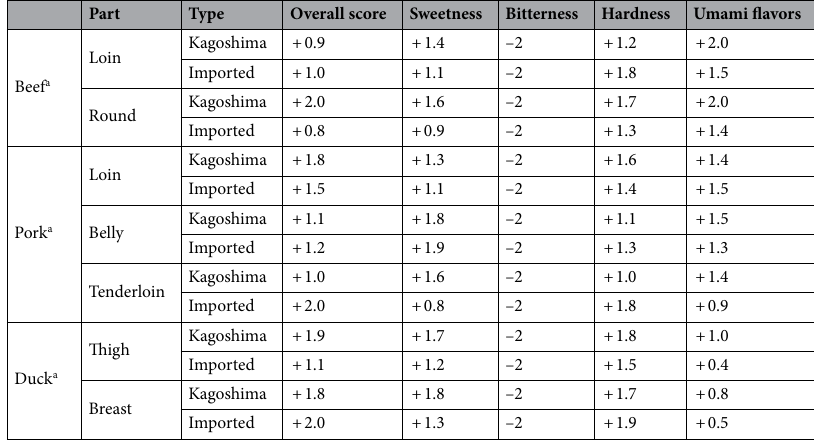
Table 3. Overall sensory evaluation of cooked meat. a Cooked meat samples (beef, pork, and duck) were comprehensively evaluated for sweetness, bitterness, hardness, and umami flavors using sensory evaluation. Each item was rated on a five-point scale, ranging from + 2 to –2. A higher score indicated better overall sensory quality. Samples were evaluated by 19 trained panelists.